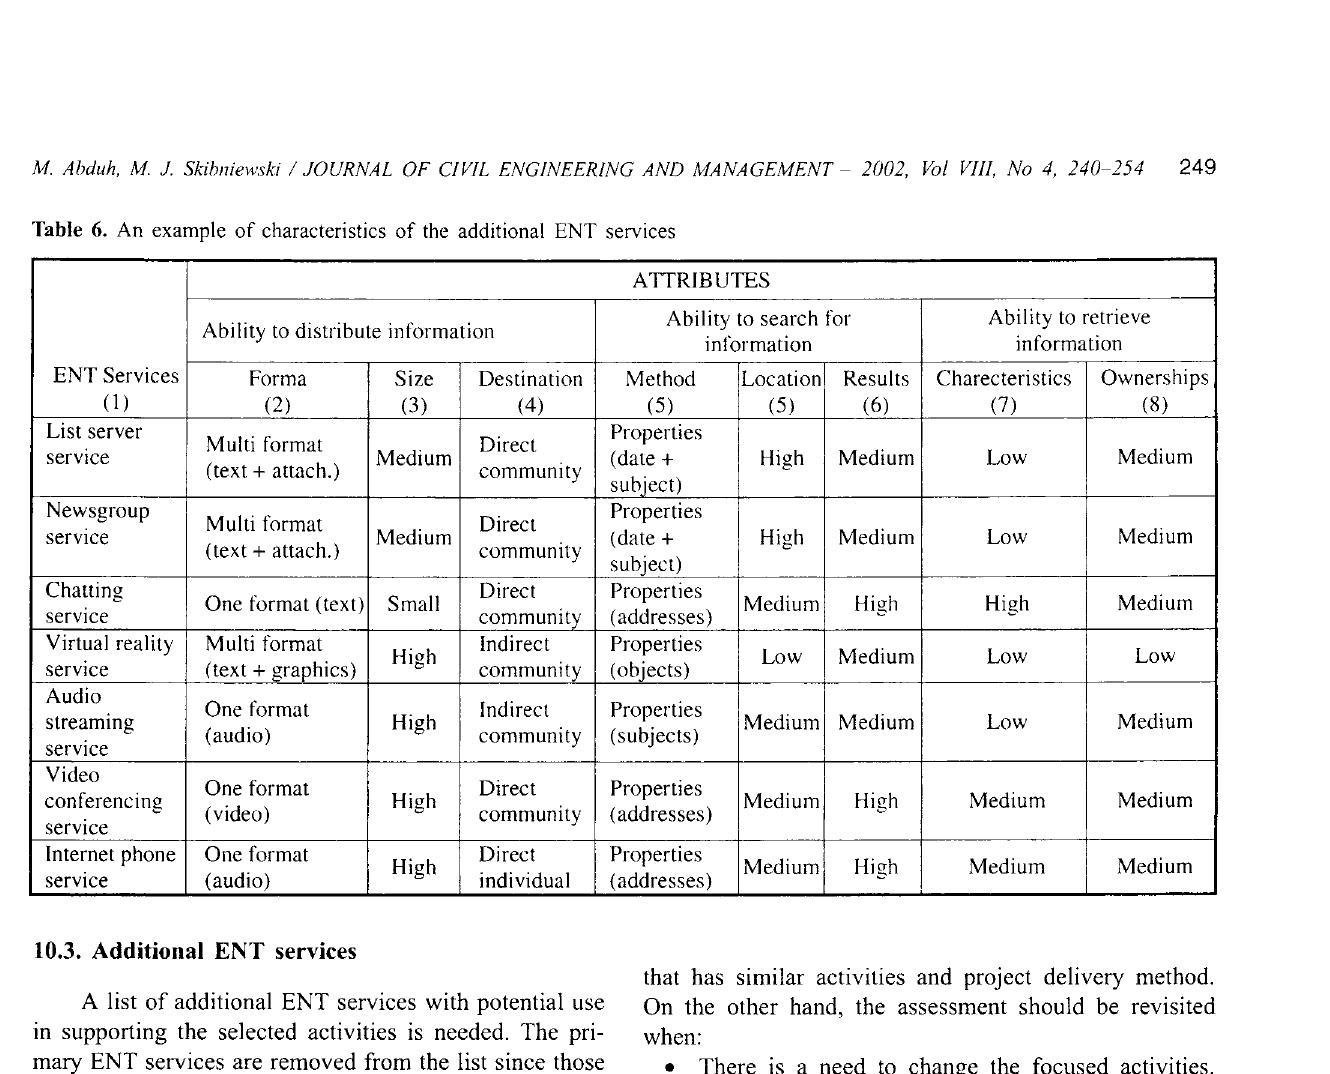
Ability to distribute